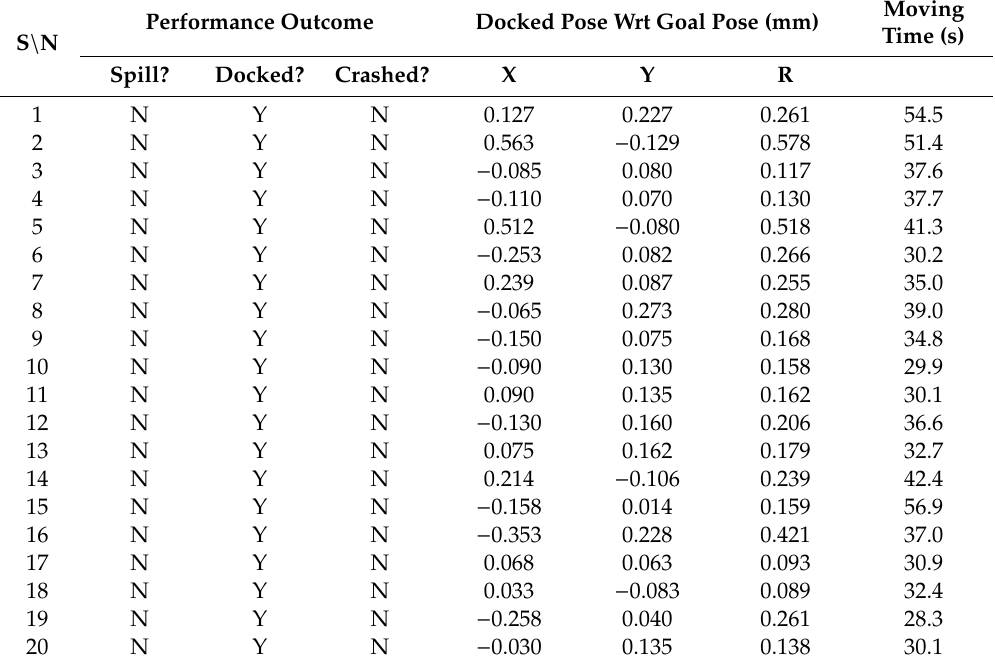
Table 3. Performance results of VelProSMACH_V2 (Strategy 3)